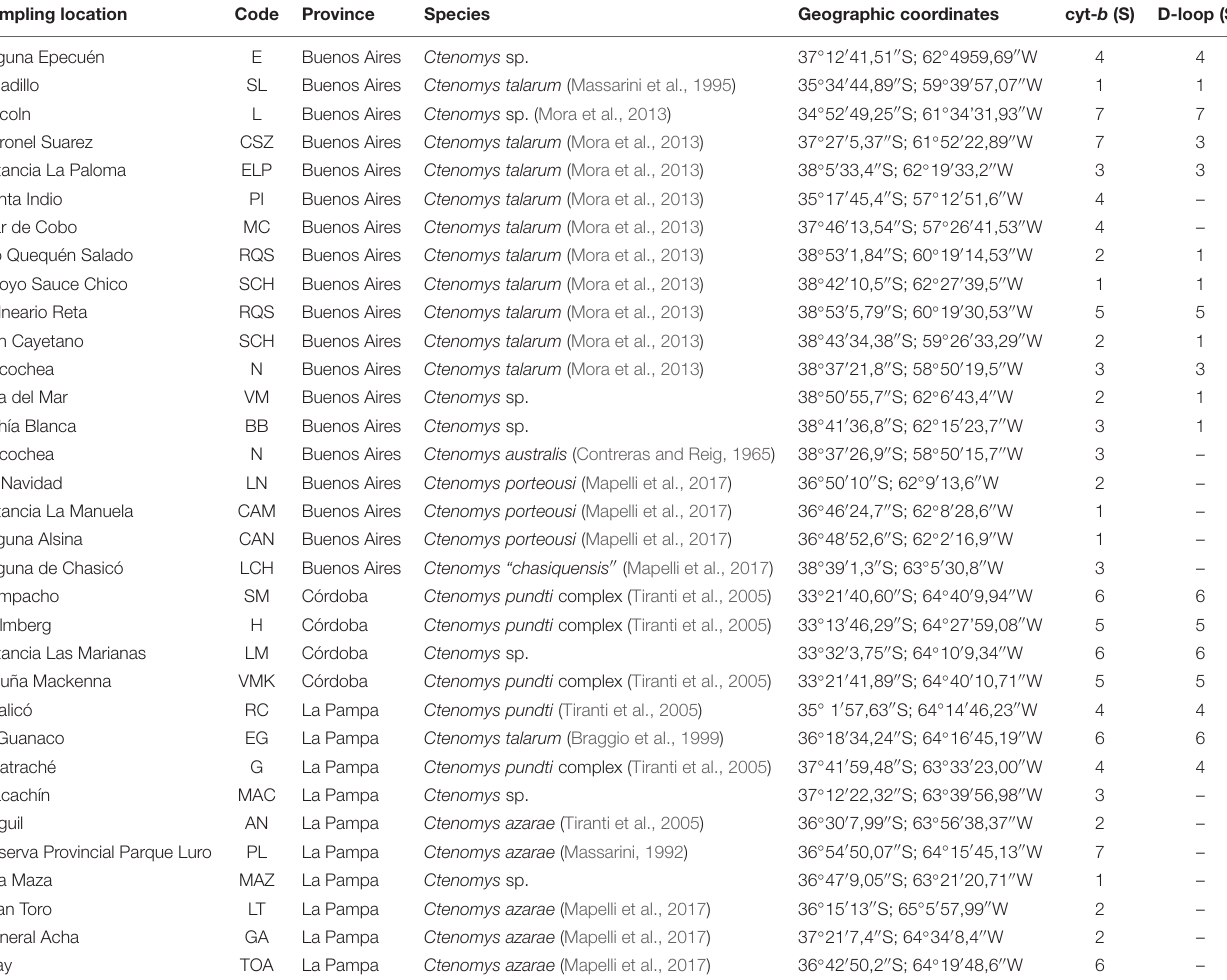
TABLE 1 | List of localities from which DNA sequences were obtained in this study. Sampling location